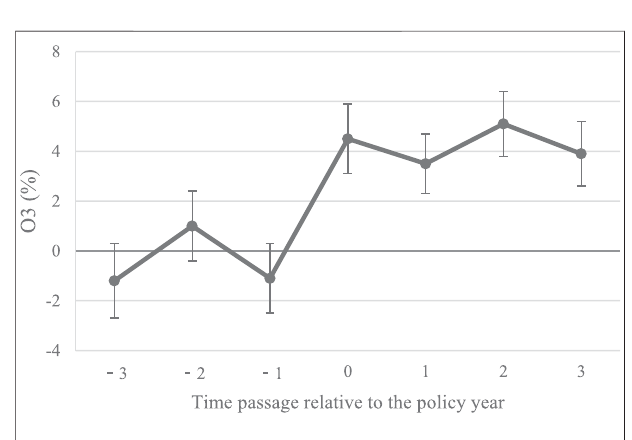
FIGURE 11 | The parallel trend test for the O 3